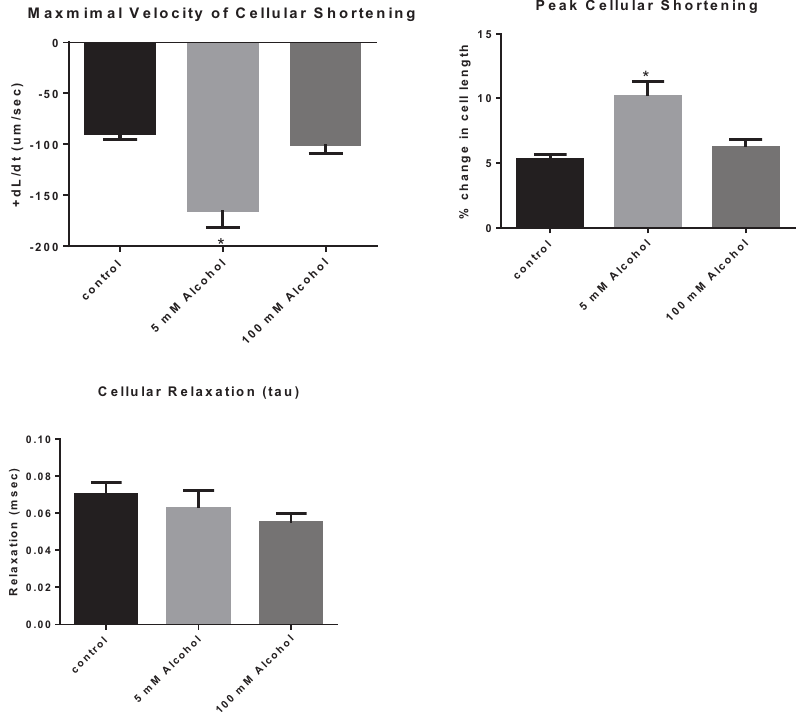
Figure 3. The effect of alcohol on cardiomyocyte contraction parameters, the maximal velocity of cellular contraction and cellular shortening, as well as on cellular relaxation. * p < 0.05 compared to